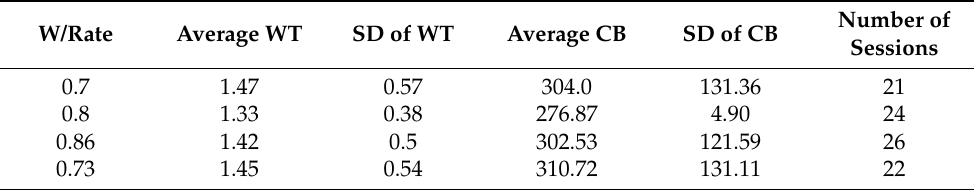
Table 3. Physiological features of users (WT—workout time, CB—calories burnt, SD—standard